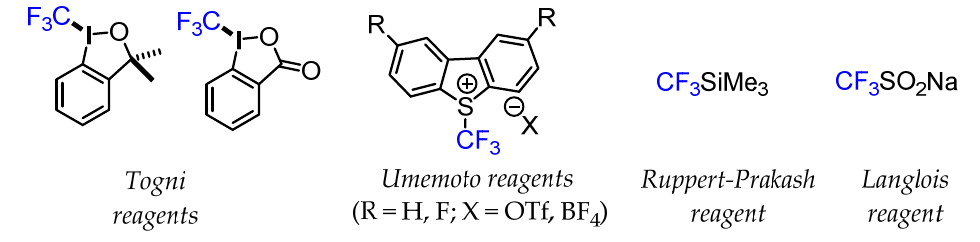
Figure 2. Examples of common trifluoromethylating reagents.